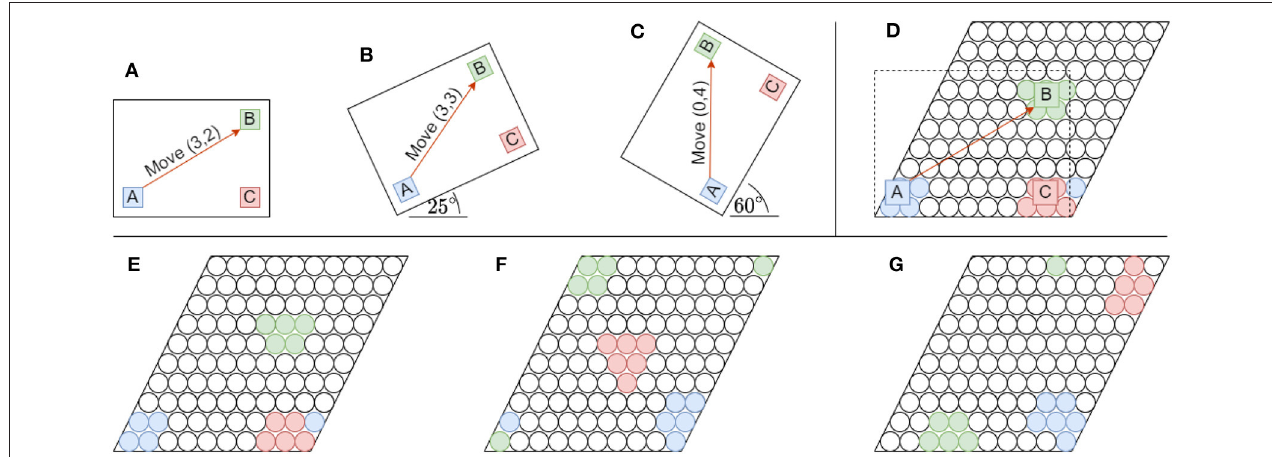
FIGURE 3 | Rotating objects have a significant impact on their underlying representation in the grid cell modules that constitute the location layer. The illustrations show how the representations of features relative to each other change on a single grid cell module. (A–C) An object consisting out of three color-coded features (A–C) are shown in three different orientations when rotated around its left-bottom corner. An orange arrow also depicts the displacement (or movement) necessary to move between the same two features (A, B) in all three orientations. The coordinate system used has an origin ( x , y ) = (0,0) anchored to the lower-left corner of the object. The object scale and movement displacements were chosen for illustrative purposes. (D) A [10 × 10] grid cell module showing the receptive fields of the original object anchored to the lower-left corner. The object is slightly scaled up when measuring its grid cell representation for illustrative purposes. Note feature A shown in blue matches receptive fields outside the original grid cell module on the lower left side. Due to tiling, the part outside of the spatial area of the module folds over to the lower right. (E–G) The grid cell representations for each of the object rotations in (A–C), respectively are shown from left to right. For illustrative purposes the lower-left corners of both the object and the grid cell module are anchored together. Note how much the relative locations of features distort when they fold over the tiling module while being rotated. These distortions completely disregard the originally-learned relative displacements between object features.